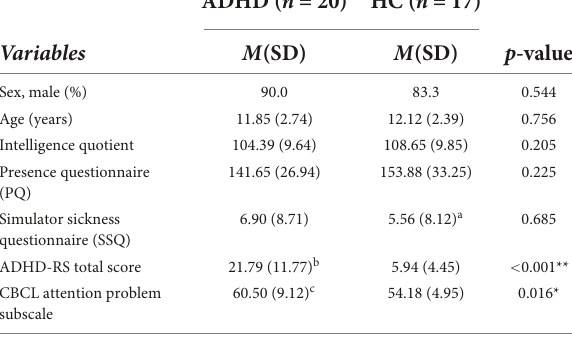
TABLE 1 Demographic and clinical characteristics.